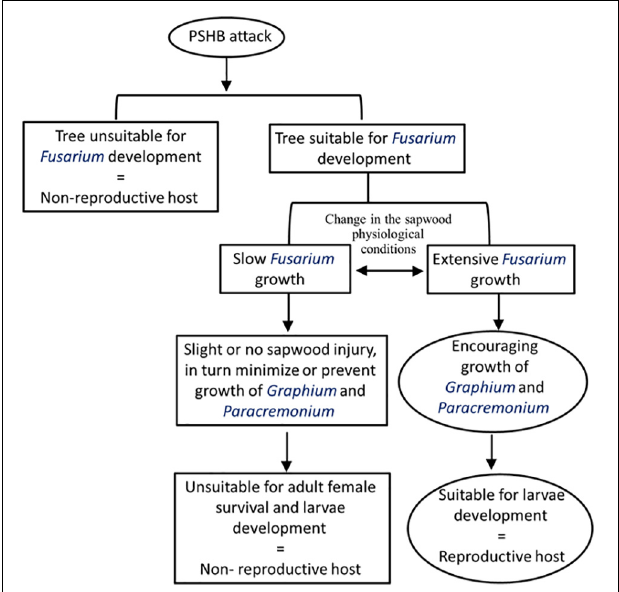
FIGURE 4 | A theoretical model explaining the relationships between the performance of Fusarium euwallaceae and the suitability of host tree species for PSHB